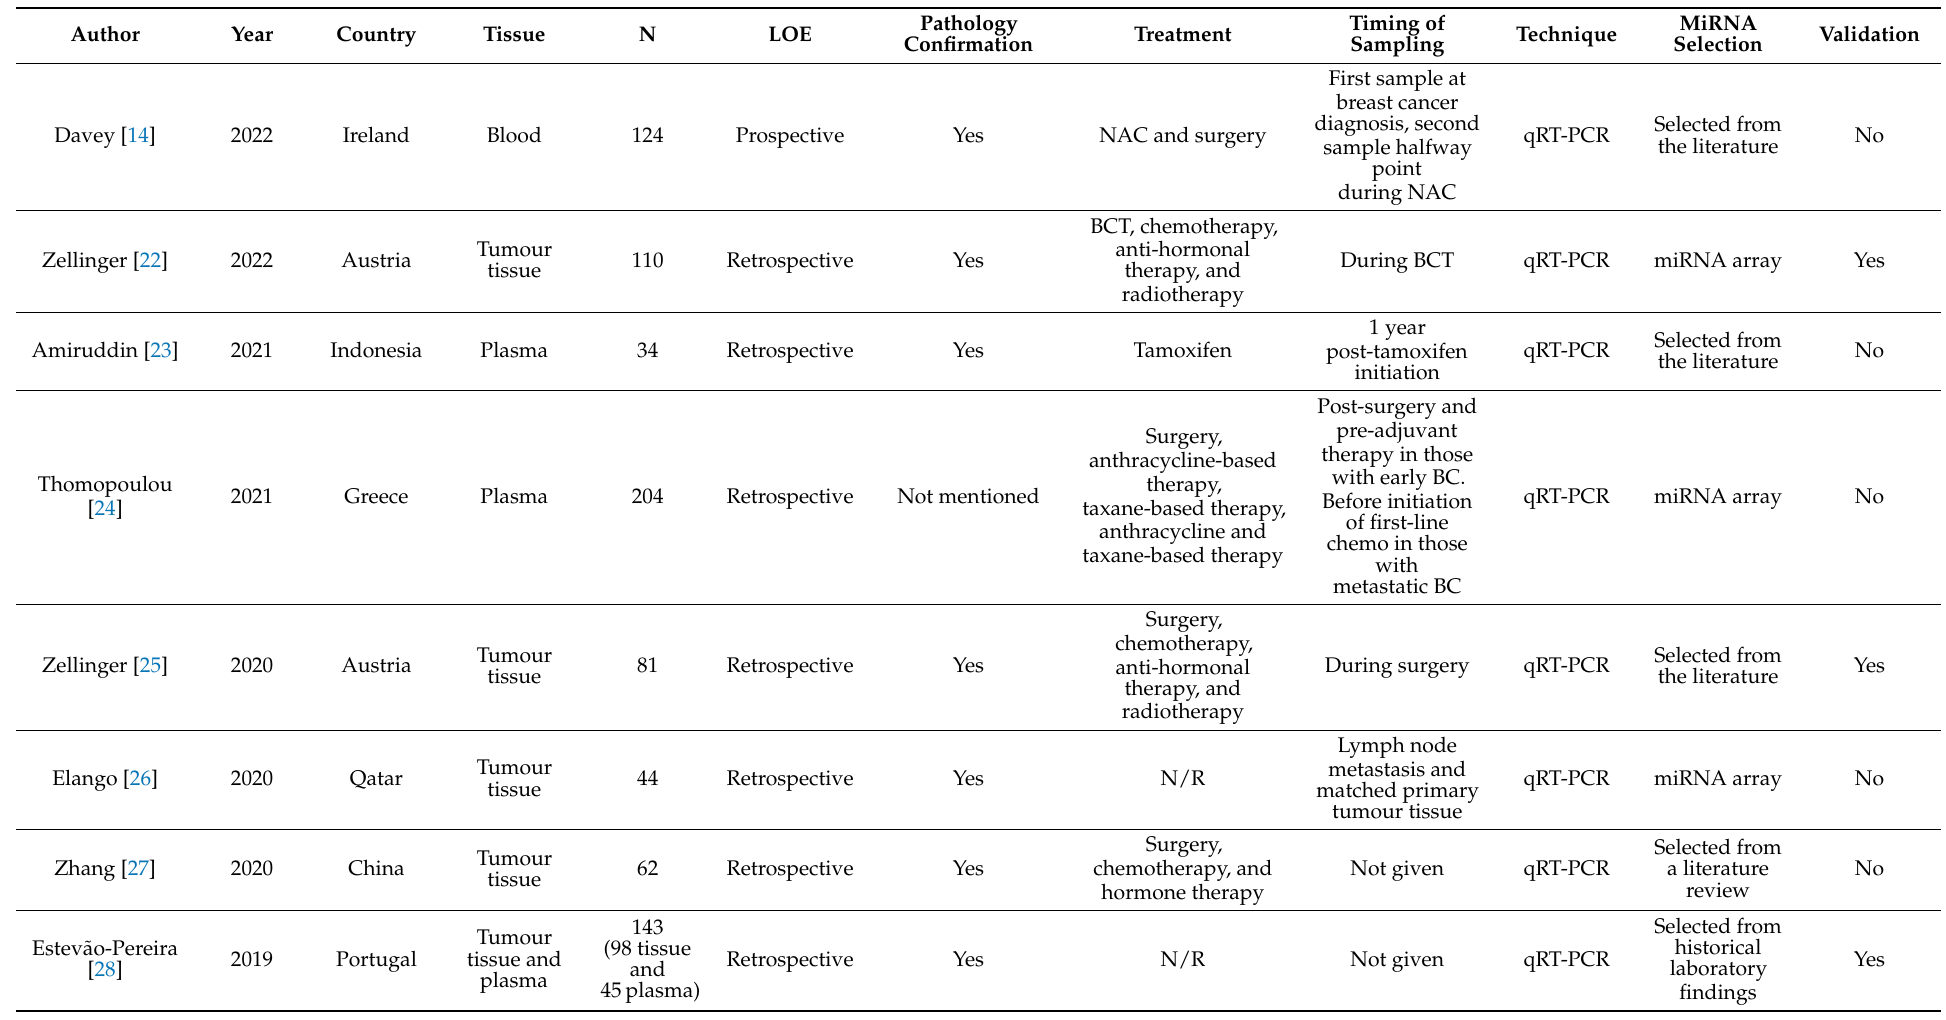
Table 1. Included studies assessing miRNA expression and their role in breast cancer